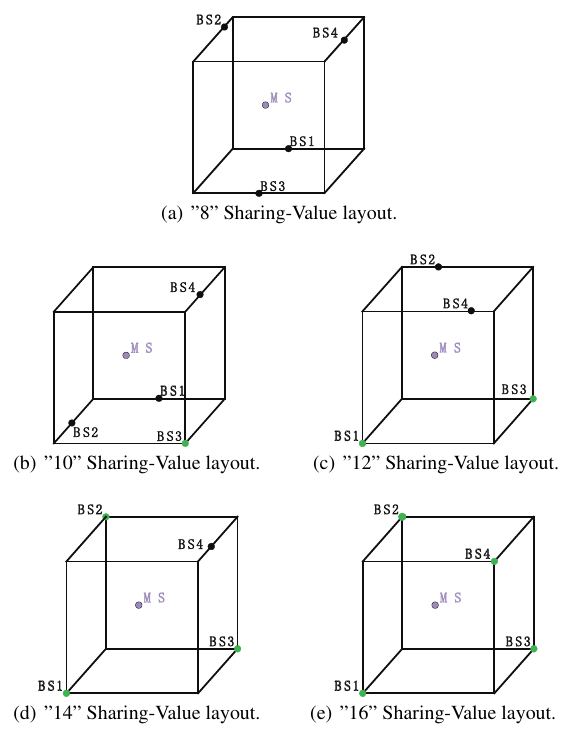
Figure 12. Optimized layout of four base stations with different Sharing-Value.